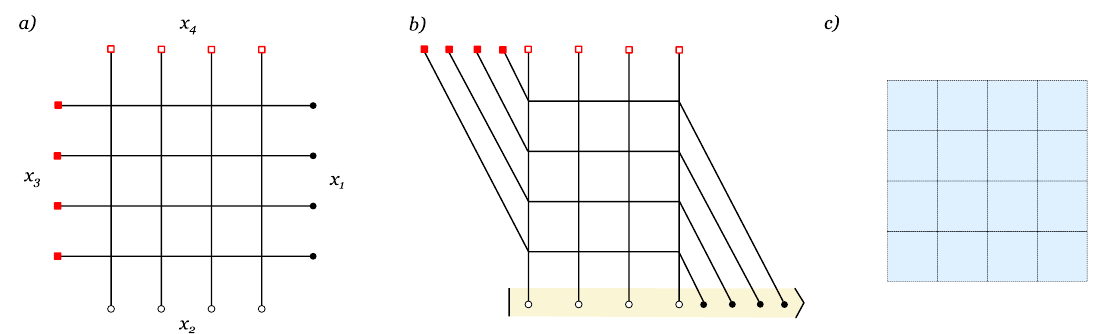
Figure 2 . Fishnet Feynman integrals of rectangular shape and the stampede. The symbols • , ◦ denote the external fields X, Z , while (cid:4) , (cid:3) are ¯ X, ¯ Z respectively. Each crossing of lines is an integration point (quartic vertex) with coupling g . Fields of the same type lie at the same space-time point. a) Rectangular fishnet of size m × n = 4 × 4 . b) The limit where the position of fields X, Z coincide, and the same for ¯ Z, ¯ X . We highlight the initial ket in the corresponding stampede process. c) Young diagram associated with the graph by replacement of each quartic vertex with a